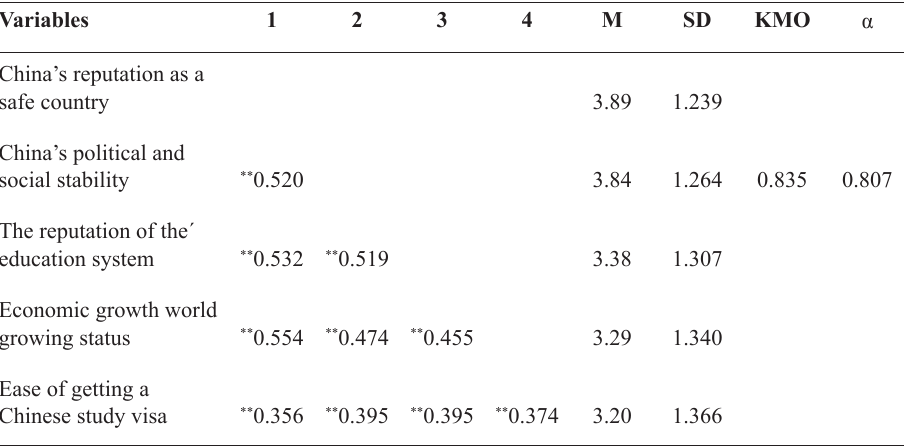
Table 7. African students’ macrosystem/global